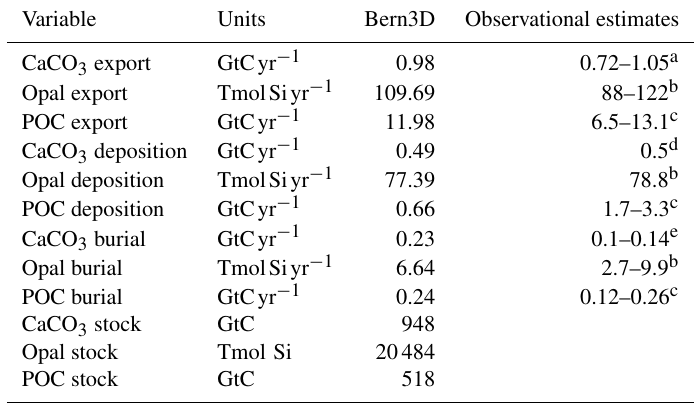
Table 1. Export, burial, and deposition fluxes, as well as sediment inventories of CaCO 3 , opal, and particulate organic carbon (POC) as determined in the model after a preindustrial spin-up and literature estimates. The tracer input flux to the ocean resulting from weathering is set to compensate for the burial fluxes diagnosed at the end of the spin-up and kept constant in Bern3D standard